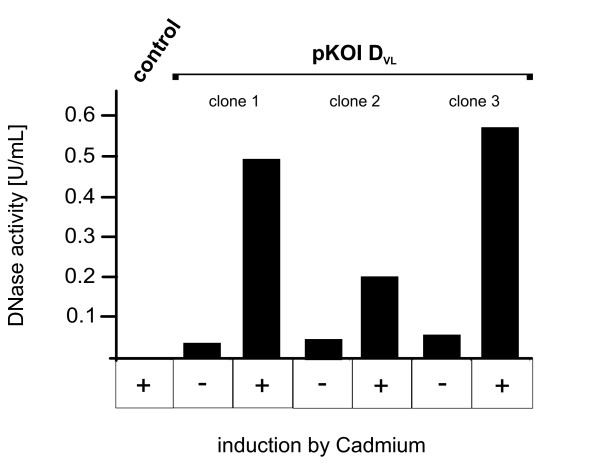
Enzyme function of knock in target. Supernatants of three clones transformed with pKOI DVL were assayed for DNase activity. Only heavy metal induced cells (+) show high levels of DNase activity. Transformed, but non-induced cells show a slightly elevated enzyme activity compared to wildtype cells due to low basal promoter activity.